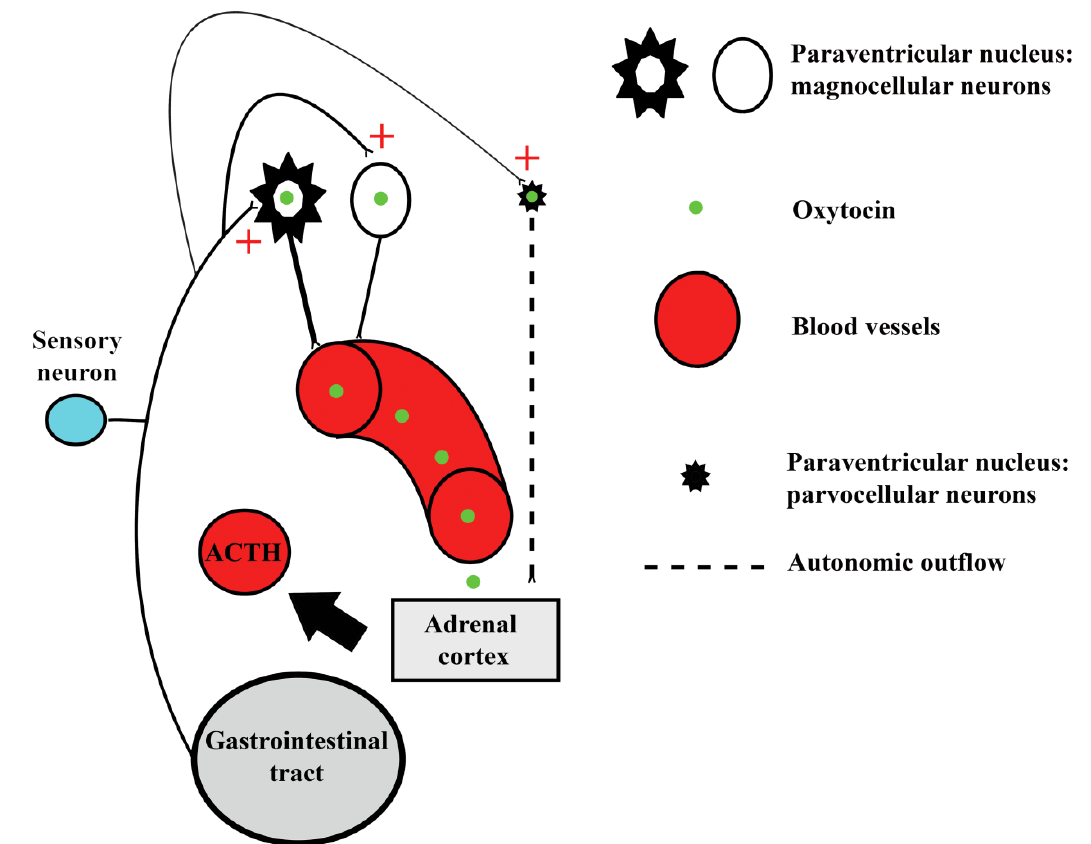
Figure 6. Oxytocin as a regulator of stress response: schematic representation. High level of stressors arising from the gastrointestinal tract increase oxytocin production in magnocellular and parvocellular neurons of the paraventricular nucleus. Magnocellular neurons modulate the adrenocorticotropic hormone (ACTH) activity through the release of oxytocin into portal circulation, whereas parvocellular neurons regulate the adrenal cortex activity via autonomic outflow.